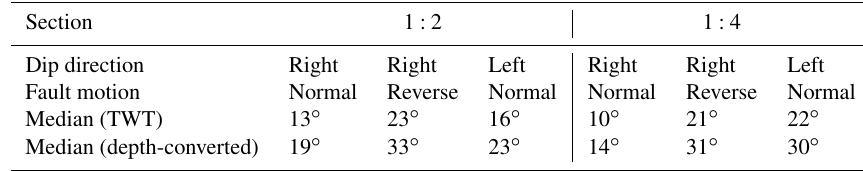
Table 1. Median values in two-way travel time and their depth-converted equivalent of the 1 : 2 and 1 : 4 sections, divided by dip direction and fault motion. The dips were depth-converted using a uniform velocity model of 3000ms − 1 (as per Stewart, 2011). Section 1 : 2 1 : 4 Dip direction Right Right Left Right Right Left Fault motion Normal Reverse Normal Normal Reverse Normal Median (TWT) 13 ◦ 23 ◦ 16 ◦ 10 ◦ 21 ◦ 22 ◦ Median (depth-converted) 19 ◦ 33 ◦ 23 ◦ 14 ◦ 31 ◦ 30